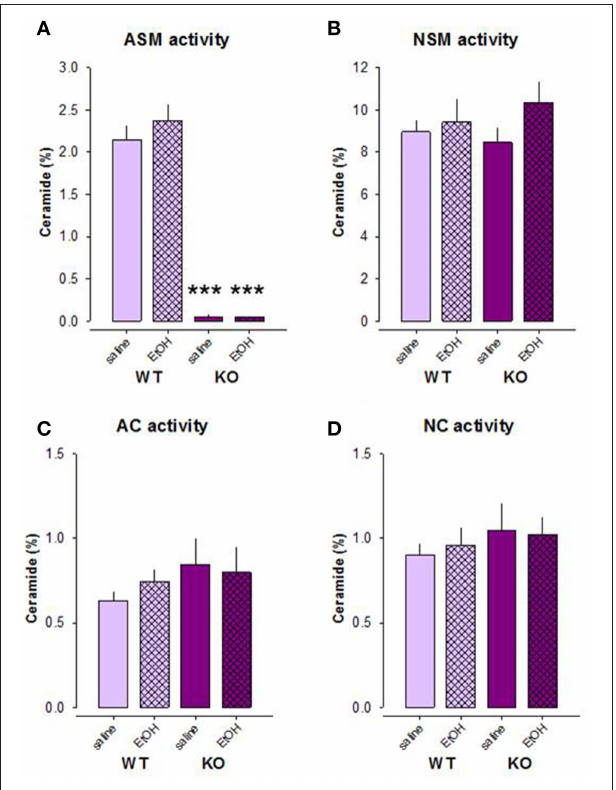
FIGURE 3 | The activity of Asm (A) is significantly lower in the dorsal hippocampus of mice with acid sphingomyelinase deficiency (KO) exposed and not exposed to alcohol treatment on the model of two-bottle free-choice drinking. No significant differences in the activities of neutral sphingomyelinase (B) , acid ceramidase (C) , and neutral ceramidase (D) are observed under these conditions. The error bars show the mean ± SEM (*** p < 0.001 vs. wt